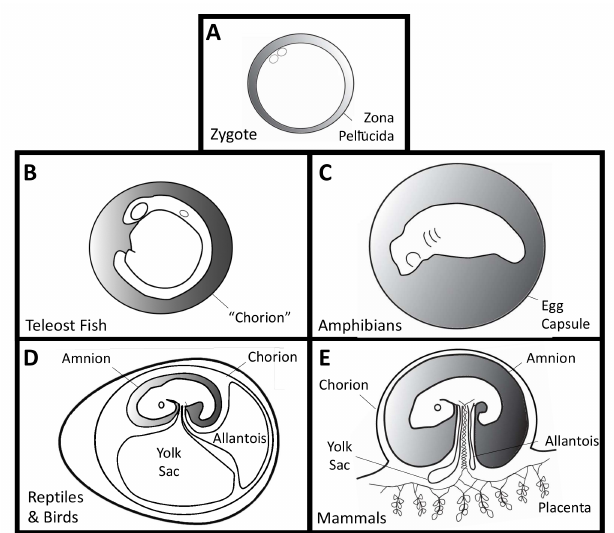
Figure 1. Vertebrate extraembryonic fluid microenvironments (shaded) and extraembryonic tissues which may harbor embryo-associated microbial life. ( A ) All vertebrates begin within a maternally- derived zona pellucida, also known as the vitelline membrane. After fertilization, perivitelline fluid surrounds the zygote and early embryo. The in ovo fluid compartment of externally developing fish ( B ) and amphibians ( C ) contains extraembryonic capsular fluid or “perivitelline fluid”, although the vitelline membrane usually ruptures during neurulation. Maternally-derived egg capsules (“chorion” in fish) surround the developing embryos and can vary in number. ( D ) Oviparous amniotes also develop in ovo inside a post-zygotic maternally-derived shell and variable cuticle. The embryo proper develops within the amniotic fluid (shaded). The extraembryonic chorion surrounds yolk, allantois, and amnion, all of which could potentially harbor embryo-associated microbes. ( E ) These membranes are also part of the in utero microenvironment of developing placental mammals, which also extend fetal circulation to interface maternal circulation in the placenta. Panels D and E are redrawn with permission from Barresi and Gilbert, Developmental Biology, 11th edition. Published by Oxford University Press